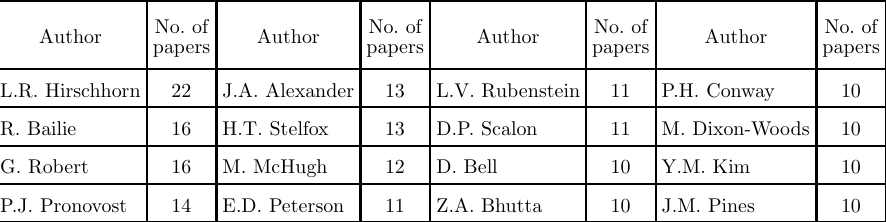
Table 1. List of authors of the largest numbers of publications related to the management of medical services in the Scopus database in 2011–2017 No. of No. of No. of